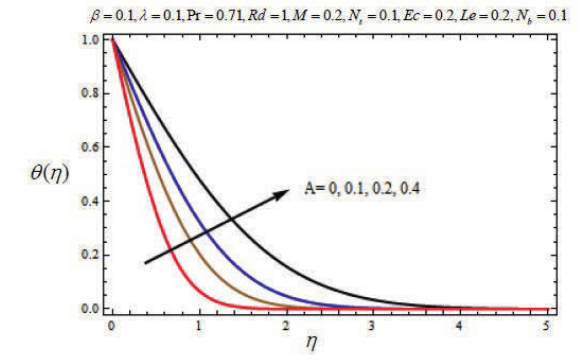
Fig. 14: Variation of temperature profile θ ( η ) with η for several val- ues of heat source parameter A > 0 .